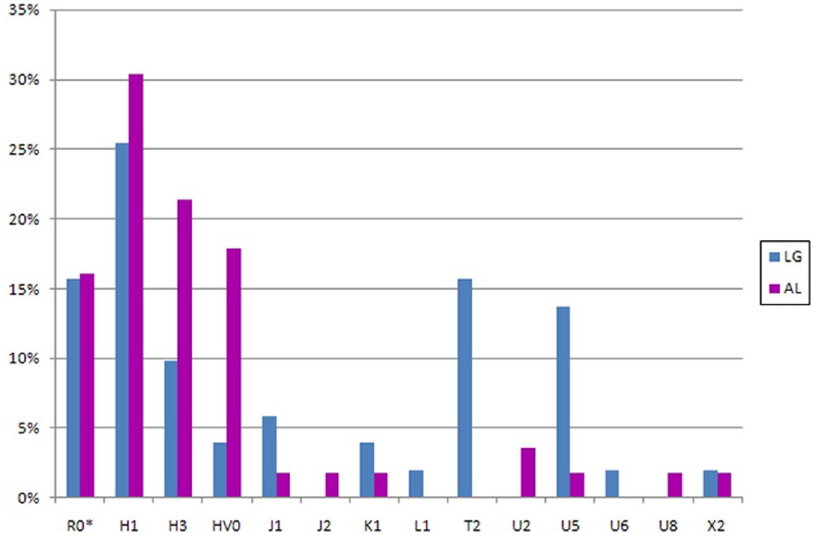
Fig 4. MtDNA haplogroup composition of Laguardia (LG) and Alava (AL) population sample sets. R0 * includes H and HV lineages except for H1, H3, and